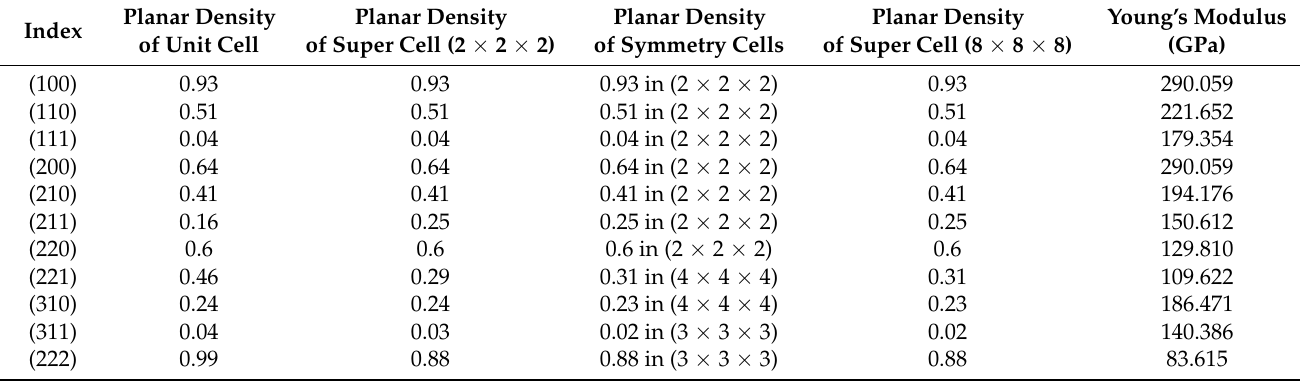
Table 2. Planar density and Young’s modulus values of the unit cell, super cells (2 × 2 × 2) and symmetry cells of CaTiO 3 .